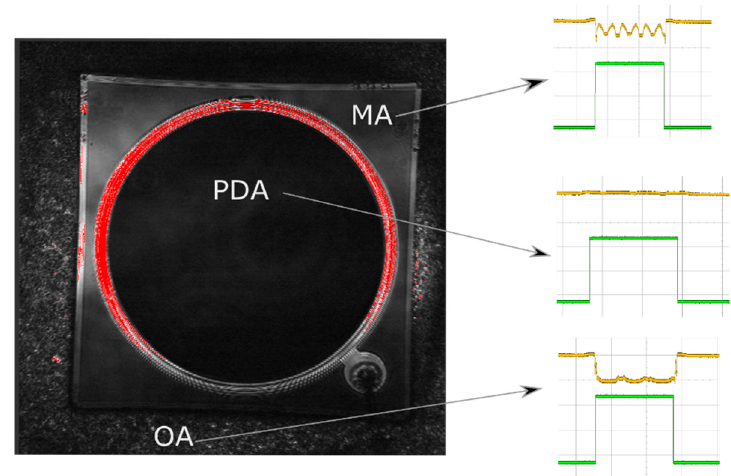
Figure 3. Waveform for each area in a photodiode.